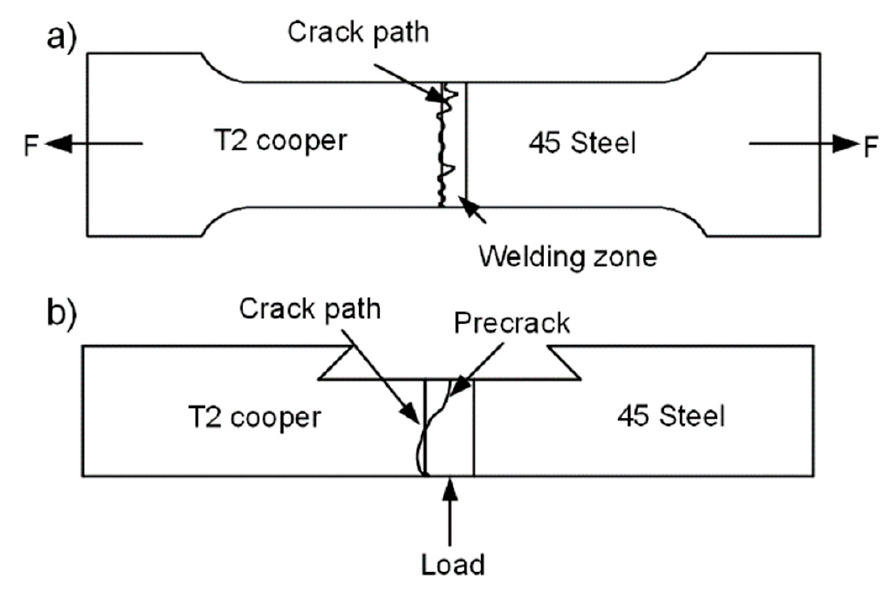
Figure 13. Crack deflection diagram ( a ) Standard tensile test; and ( b ) Three-point bending test. Therefore, the crack propagation path of T2 copper/45 steel dissimilar welding materials always deflected to the low strength side of the T2 copper because the strength mismatch between three regions was comparatively large and the toughness decreases from the weld area to HAZ and then the base metal.